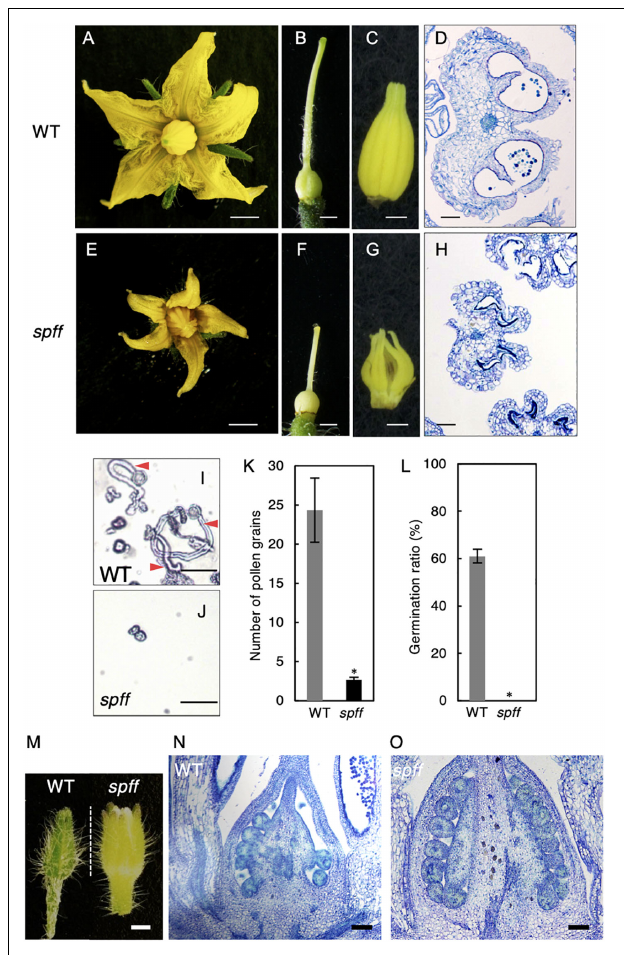
FIGURE 4 | Reproductive organ phenotypes in the spff mutant. Morphology of flower (A,E) , pistil (B,F) , and anthers (C,G) in WT (A–C) and spff (E–G) at anthesis. Histological sections of WT (D) and spff (H) anthers at the anthesis stage. (I) Pollen tube elongation from WT pollen. Red arrowheads indicate pollen tubes. (J) Pollen grains from the spff mutant, without elongation of pollen tubes. (K) Number of pollen grains in a microscopic field. (L) Germination ratio of pollen tubes. (M) Appearance of floral bud length of 4 mm. Longitudinal section of ovaries from 4 mm floral buds (M) in WT (N) and spff (O) . Bars are 2 mm (A,E) ; 1 mm (B,C,F,G) ; 100 µ m (D,H,N,O) , and 50 µ m (I,J) . At least three biological repetitions were performed and their mean values with SE are shown. Asterisks indicate significant difference between WT and spff mutant (Student t -test, p <